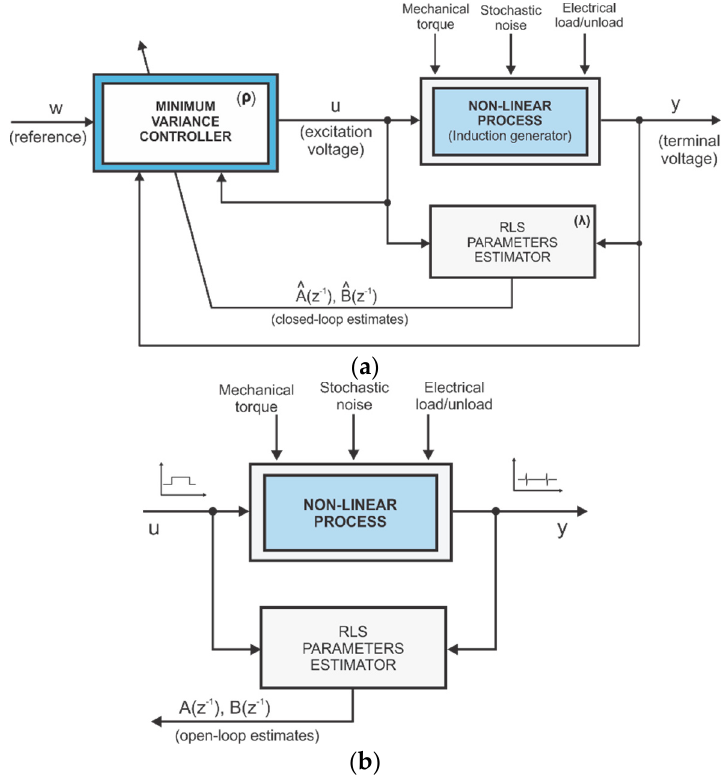
(cid:0) (cid:1) (cid:0) (cid:1) z − 1 z − 1 , ˆ B ); ( b ) open-